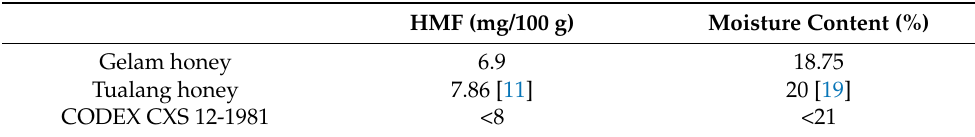
Table 1. Hydroxymethylfurfural (HMF) and moisture